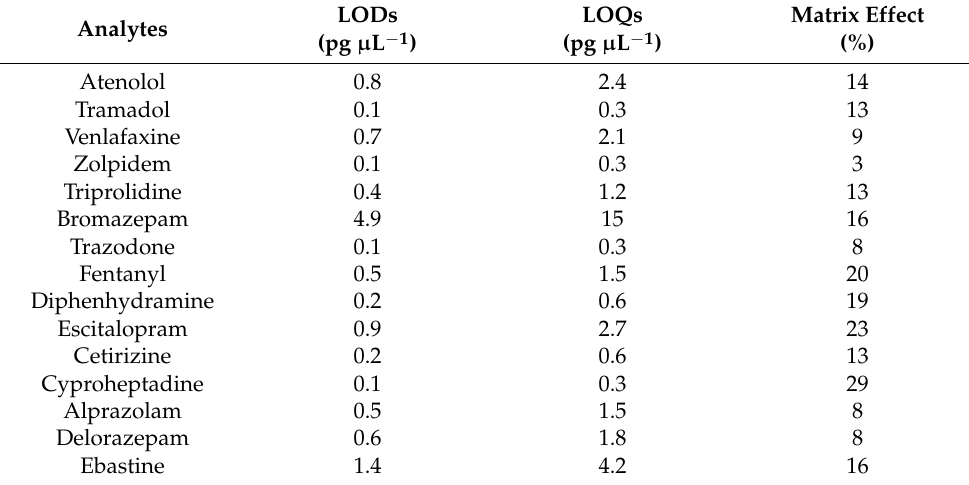
Table 3. Limits of Detection and Quantitation (calculated on the less intense MRM transitions) and matrix effect expressed as decrement of the calibration curve slope. Values of LODs and LOQs were evaluated in whole blood samples as a result of 6 replicates to confirm the